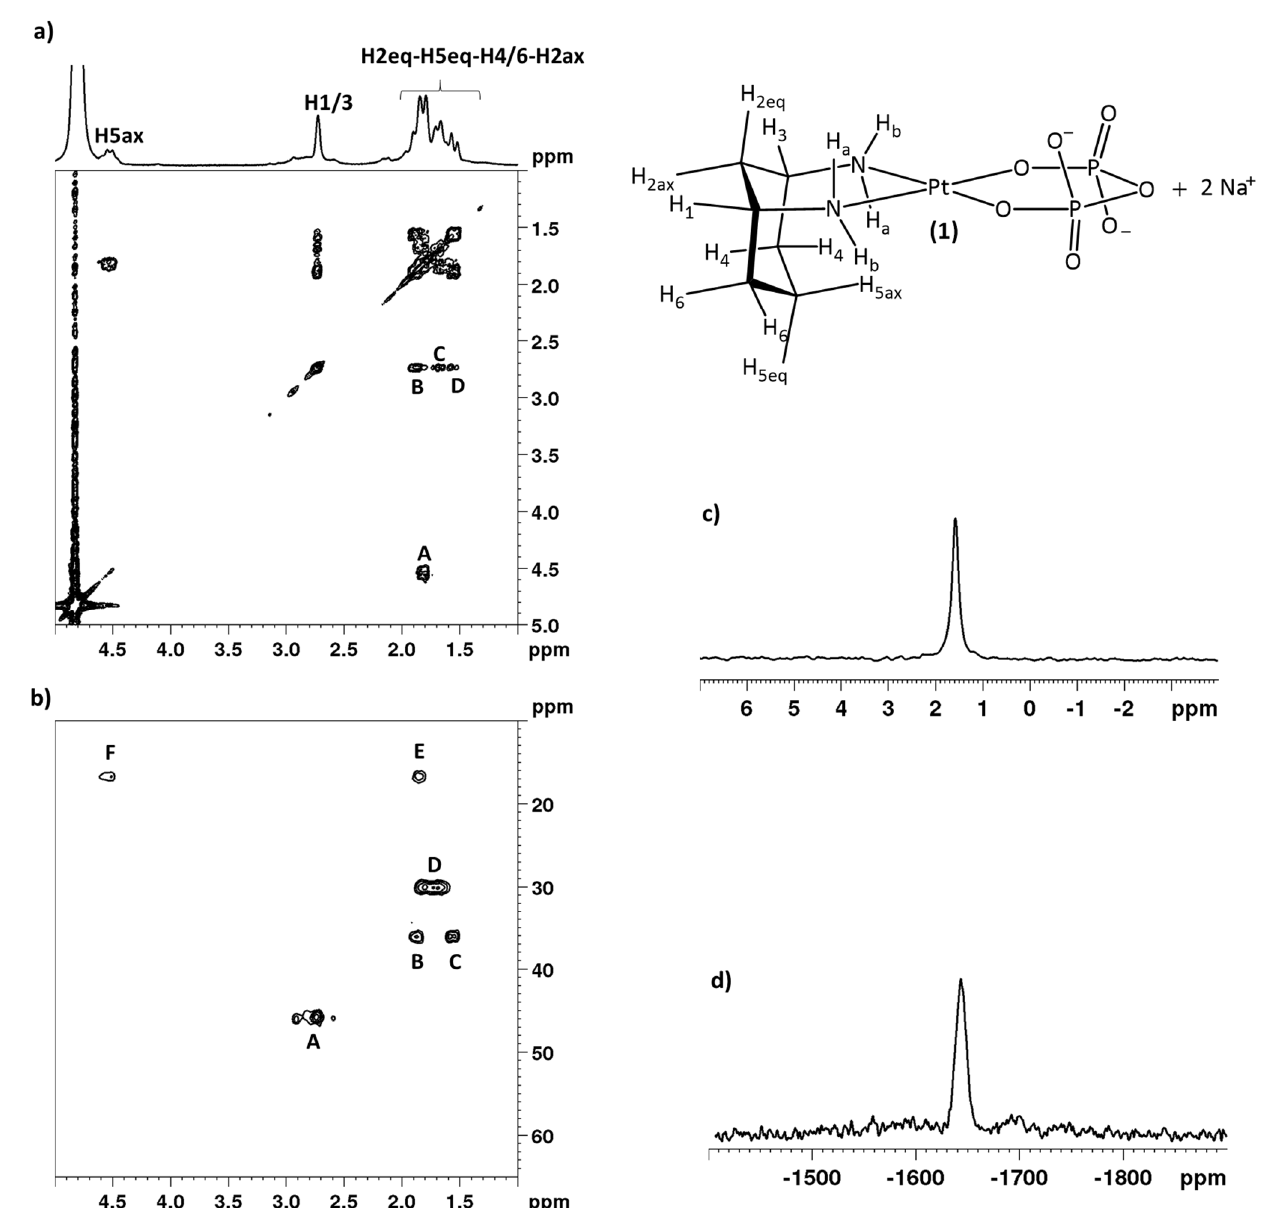
Figure 2. ( a ) COSY (300 MHz), ( b ) [ 1 H- 13 C] HSQC ( 13 C, 75.5 MHz), ( c ) 31 P{ 1 H} (121.5 MHz), and ( d ) 195 Pt{ 1 H} (64.5 MHz) NMR spectra of 1 dissolved in D 2 O.